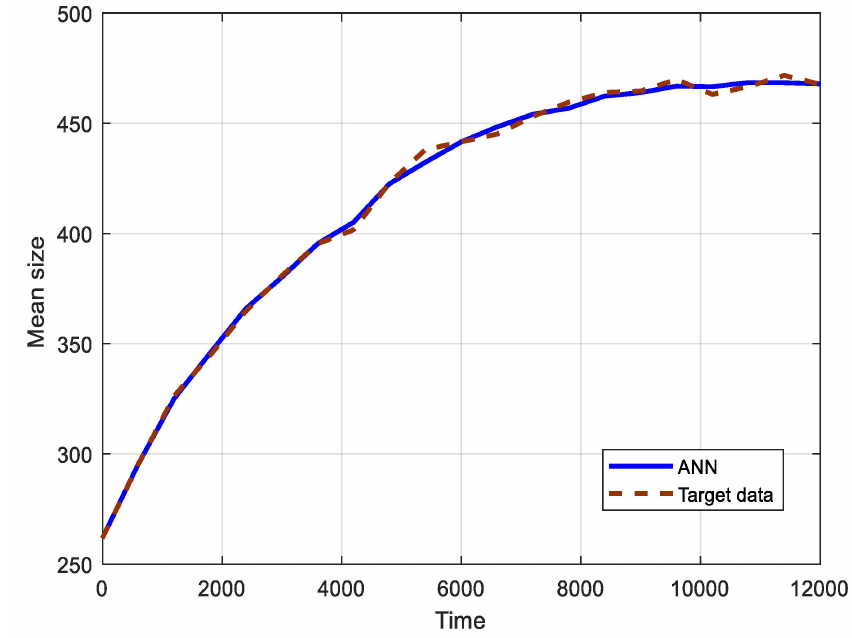
Figure 7. Validation of the ANN compared to the target experimental